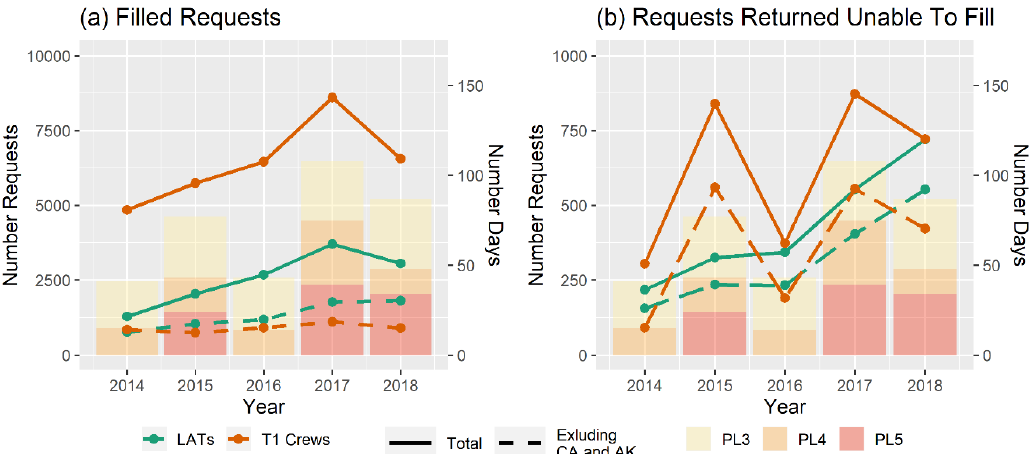
Figure 3. The number of large airtanker and type 1 crew ( a ) filled requests and ( b ) requests returned Unable to Fill in ROSS by calendar year against the number of days at or above Preparedness Level 3 for calendar years 2014–2018. The solid lines all requests within the US. The dashed lines are for all requests except California and Alaska.